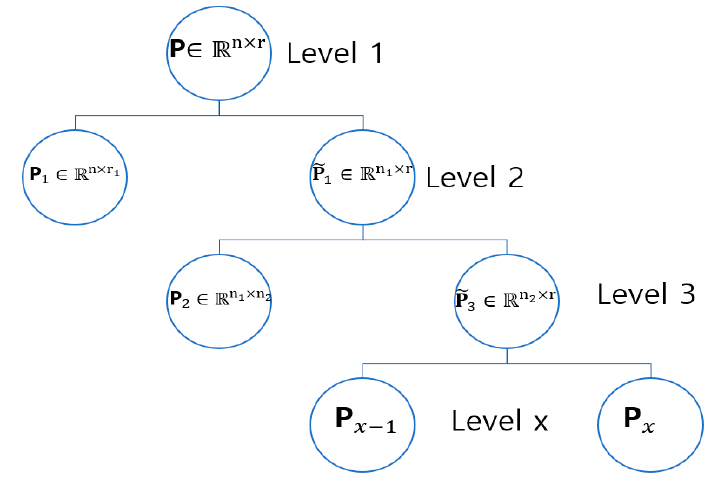
Figure 6. Generating customer’s implicit dormant features.